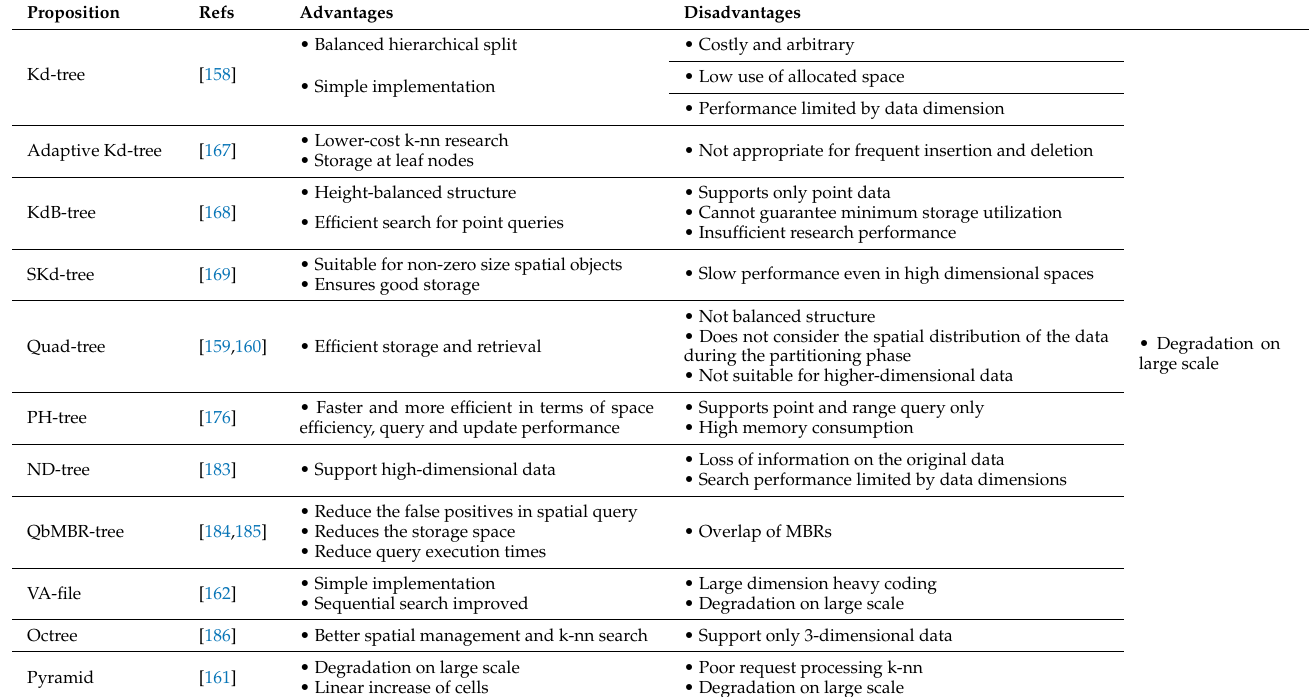
Table 10. Summary of advantage and disadvantage of multidimensional indexing techniques based on space